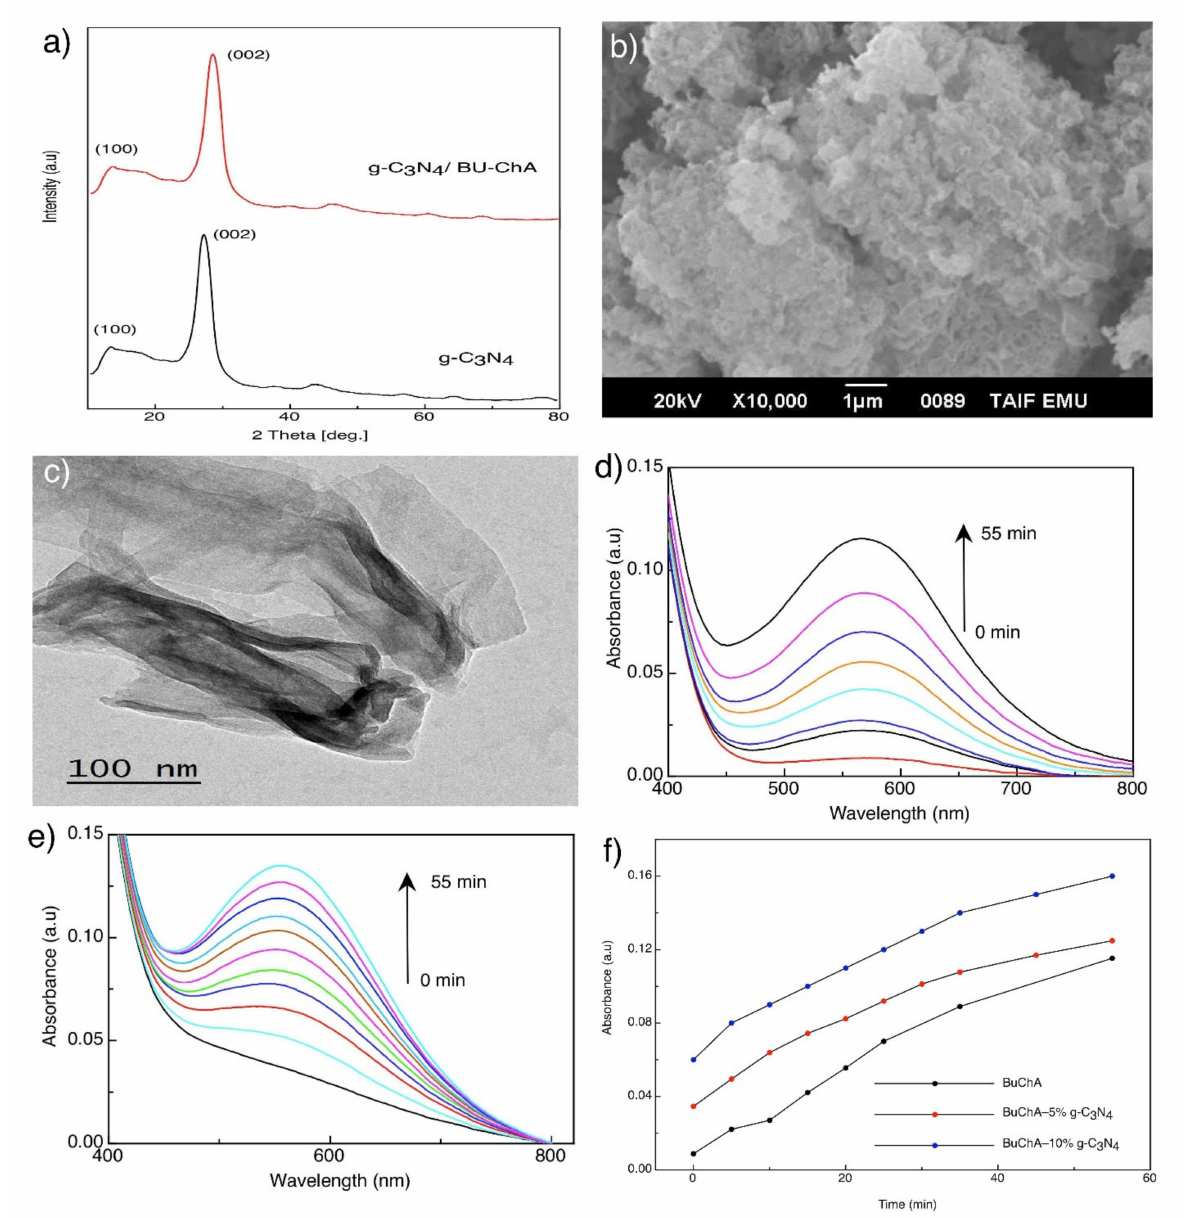
Figure 6. ( a ) XRD pattern, ( b ) SEM of g-C 3 N 4 , ( c ) TEM of the g-C 3 N 4 nanosheet, ( d ) effect of time on the absorption spectra of BUChA, ( e ) effect of time on BUChA/5% g-C 3 N 4 , and ( f ) Time-absorbance relation in methanol.